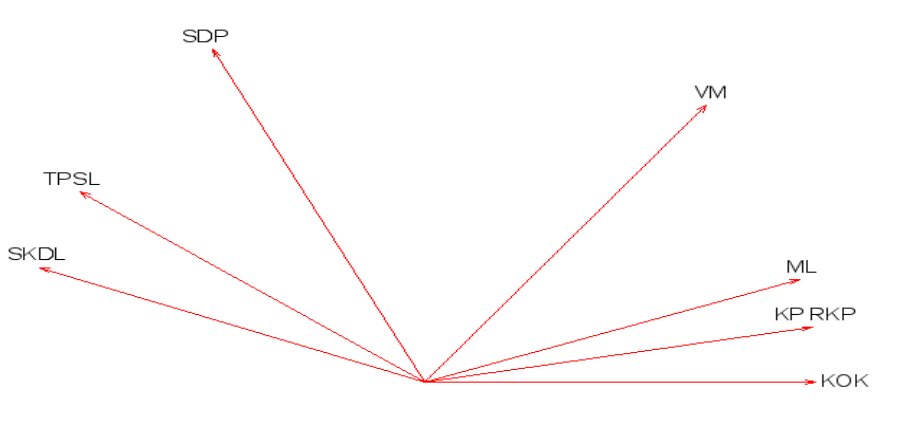
Figure 1. Government and opposition voting during the Virolainen government